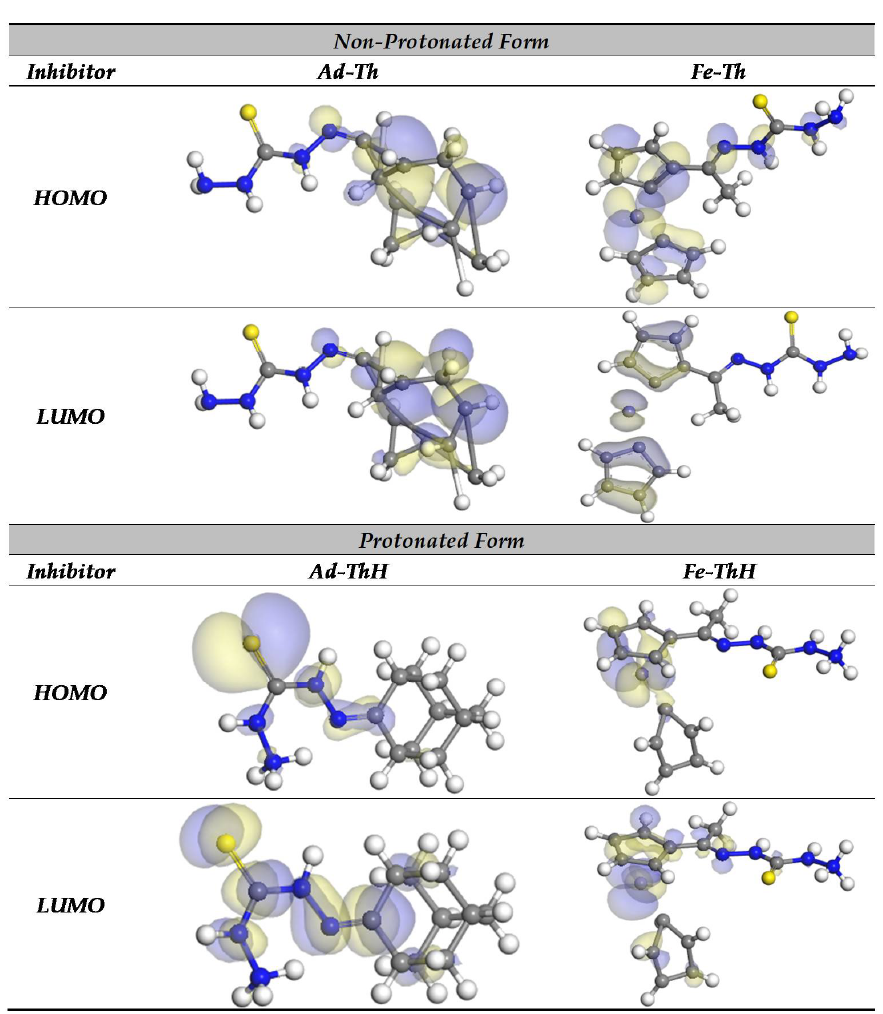
Figure 9. HOMO and LUMO of the protonated and non-protonated Ad-Th and Ad-Fe molecules using DMol3 module.